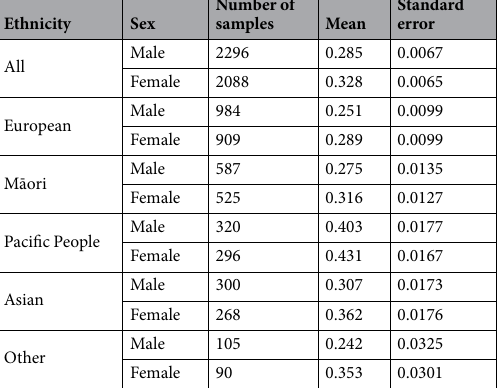
Table 1. Log transformed relative telomere length across participants who consented and provided a saliva sample, partitioned by child ethnicity and sex.